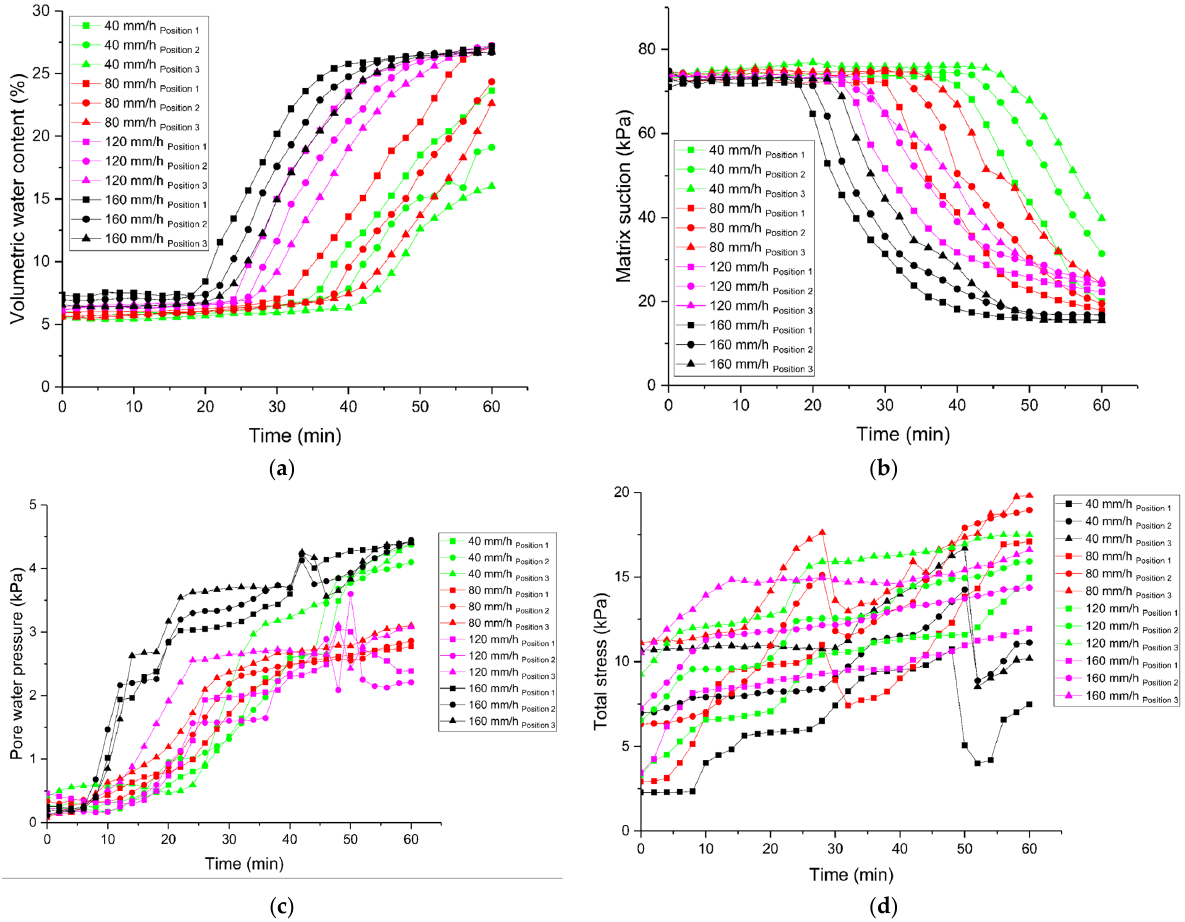
Figure 5. Variation in measured data when rainfall intensity is different: ( a ) water content; ( b ) matrix suction; ( c ) pore water pressure; ( d ) total stress.